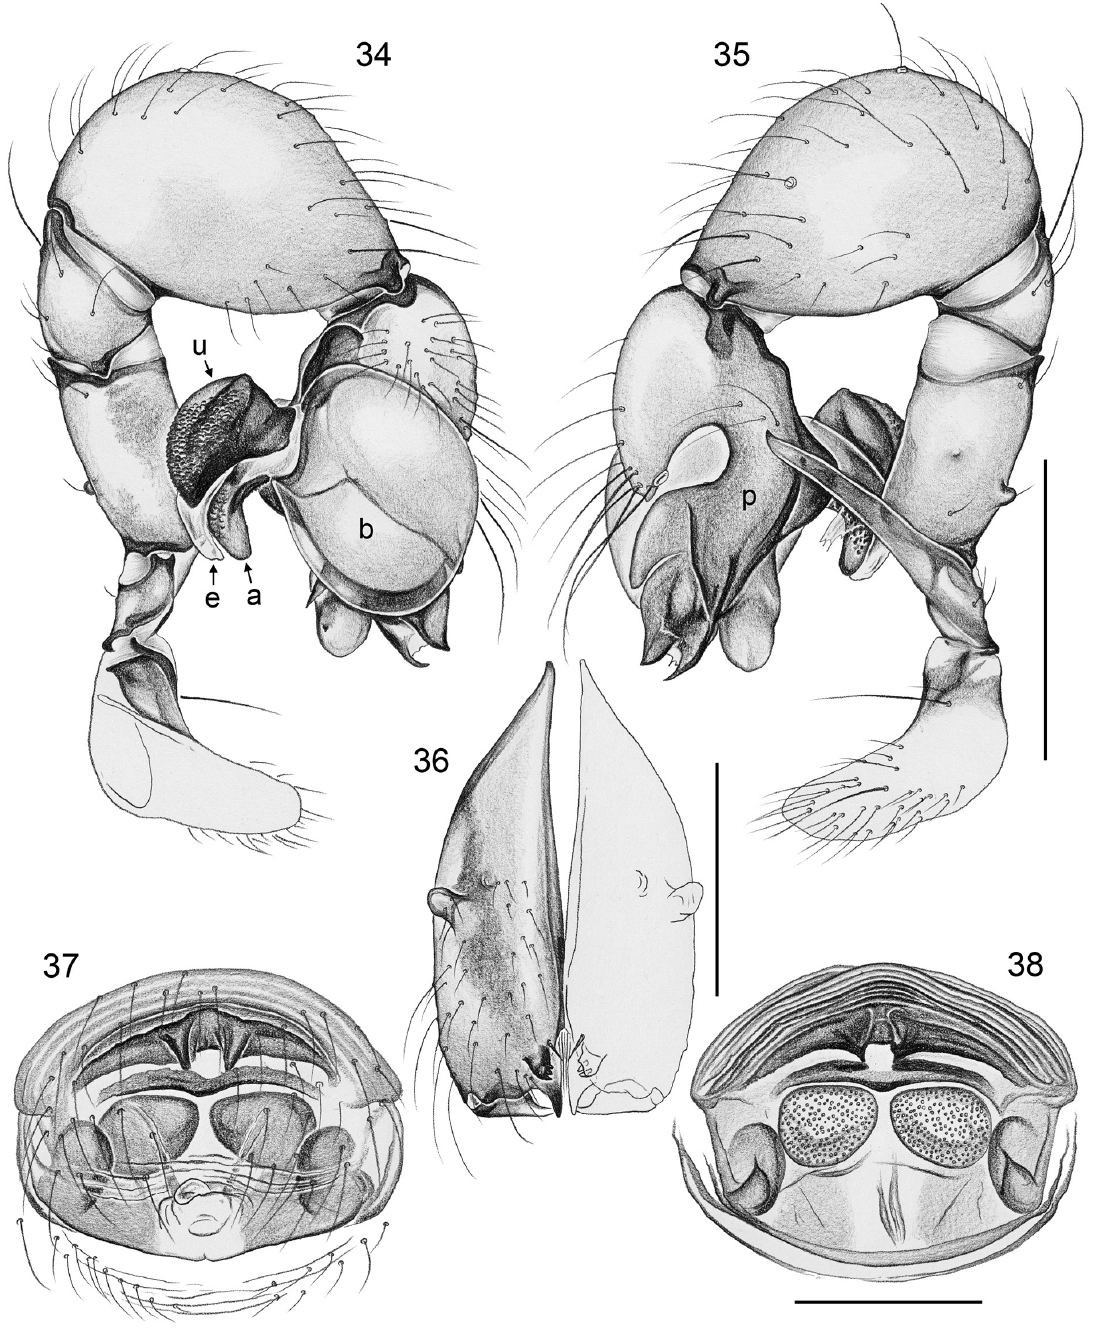
Figs 34–38. Pholcus lintang Huber, sp. nov., ZFMK Ar 15015. 34–35 . Left male palp, prolateral and retrolateral views. 36 . Male chelicerae, frontal view. 37–38 . Cleared female genitalia, ventral and dorsal views. Abbreviations: a = appendix; b = genital bulb; e = embolus; p = procursus; u = uncus. Scale lines: 0.3 mm (36–38); 0.5 mm